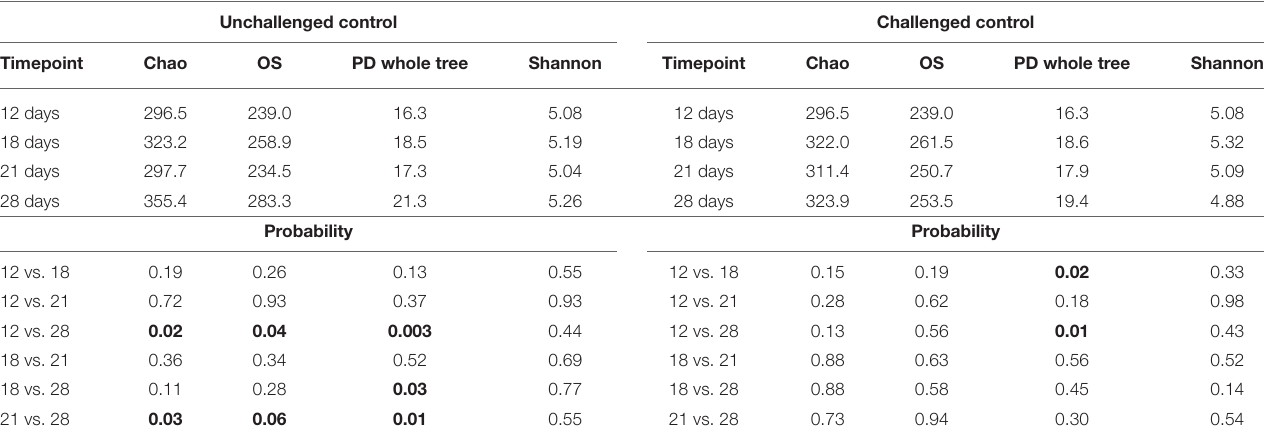
TABLE 2 | Alpha diversity indexes of the cecal microbiota of broiler chickens at different timepoints considering the unsupplemented treatments and unchallenged or challenged with a necrotic enteritis infection model. Unchallenged control